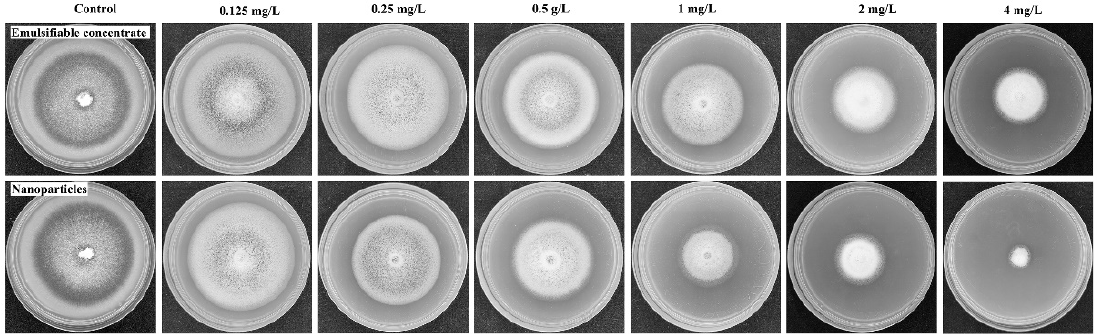
Figure 9. Fungicidal activities of prochloraz emulsifiable concentrate and PRO@DMON–GA–Fe(III) nanoparticles evaluated with Magnaporthe oryzae. Table 4. Regression equation models obtained from prochloraz emulsifiable concentrate and